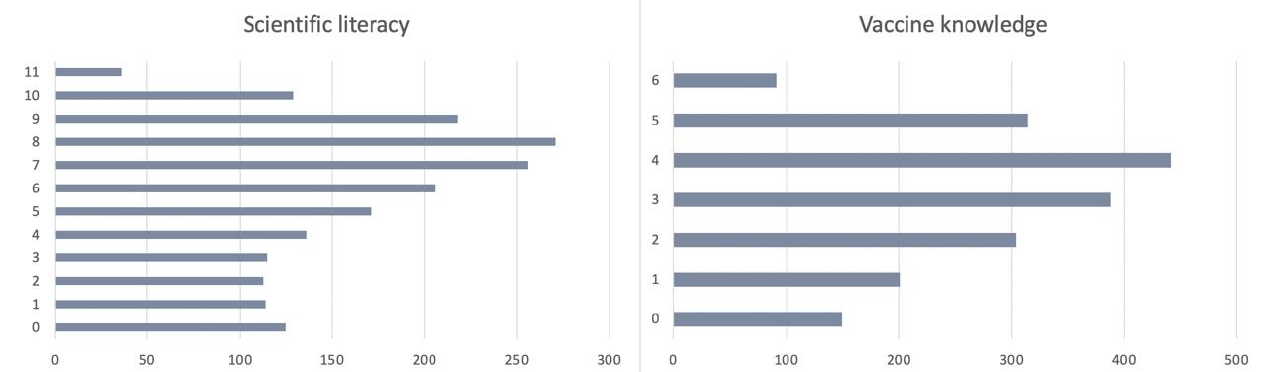
Figure 1. Level of scientific literacy and vaccine knowledge of participants ( n = 1890).